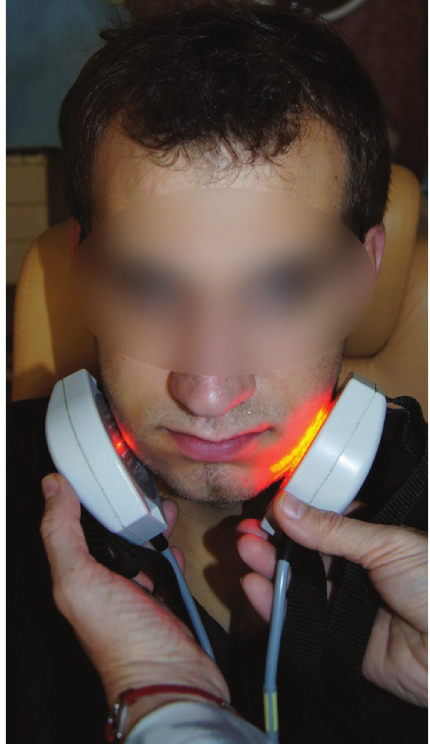
Figure 2: Applicators generating an extremely ELF EMF and light energy (830 nm and 640nm) emitted from the LEDs during the physiotherapy